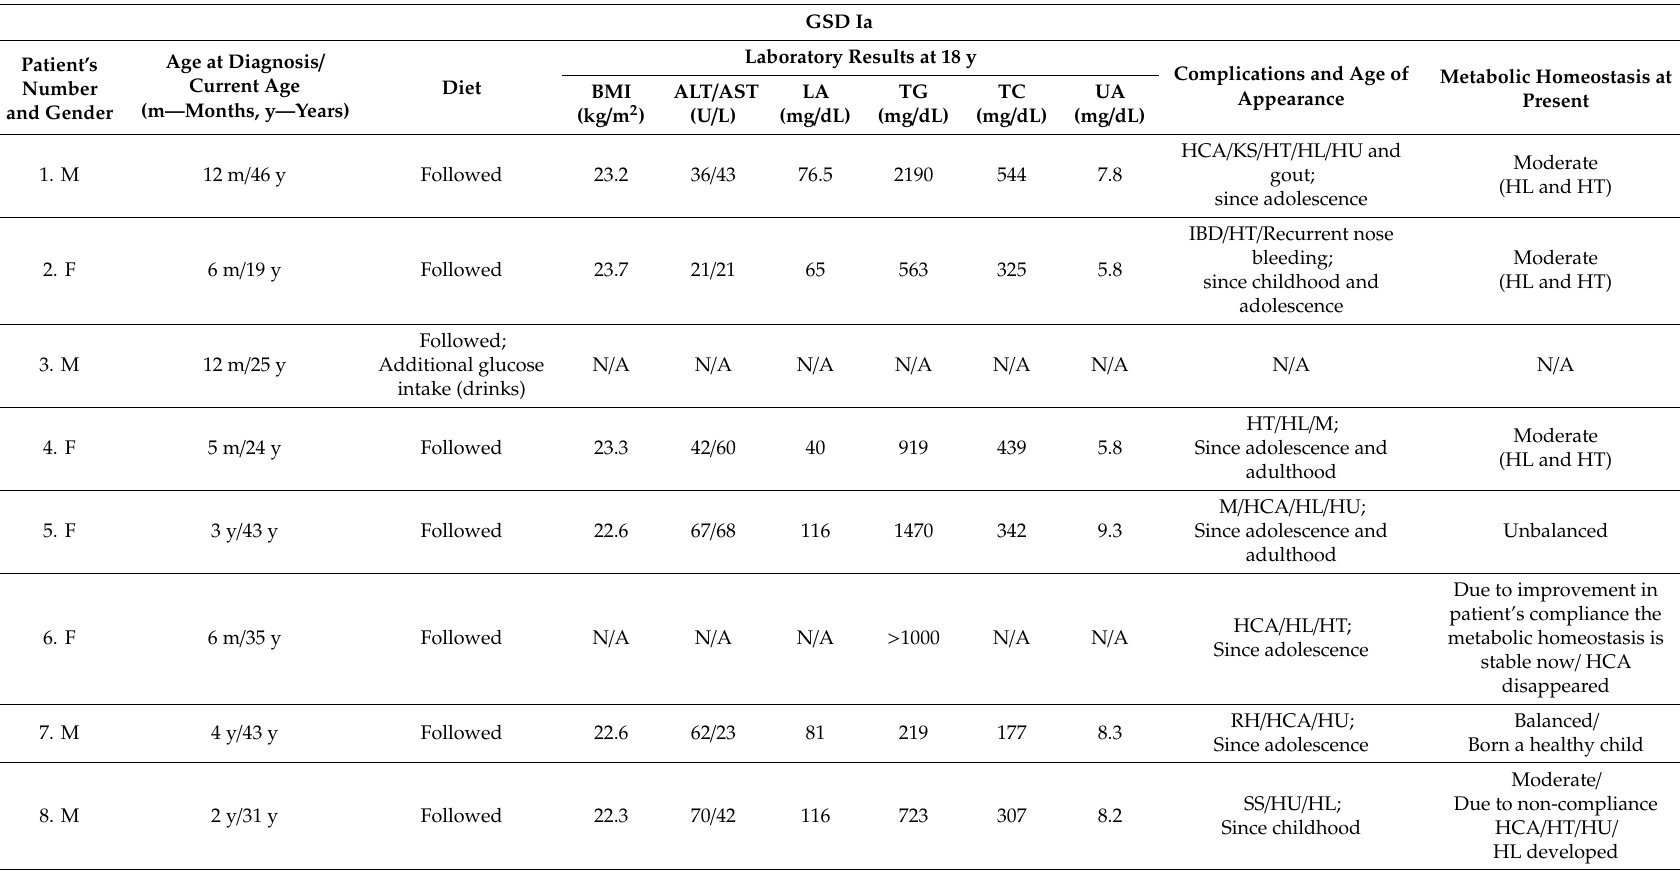
Table 1. Detailed characteristics of adult patients with GSD type I included in the study ( n =